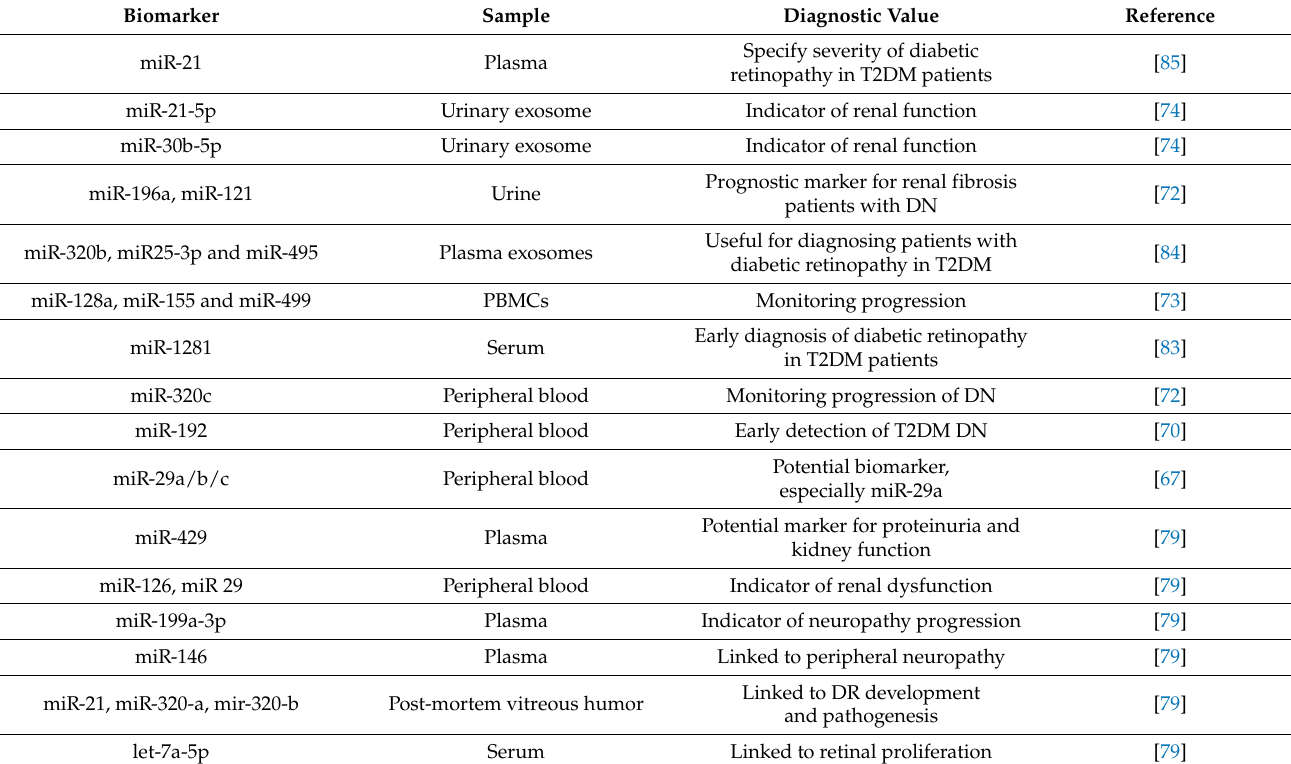
Table 2. The miRNAs that are involved in microvascular